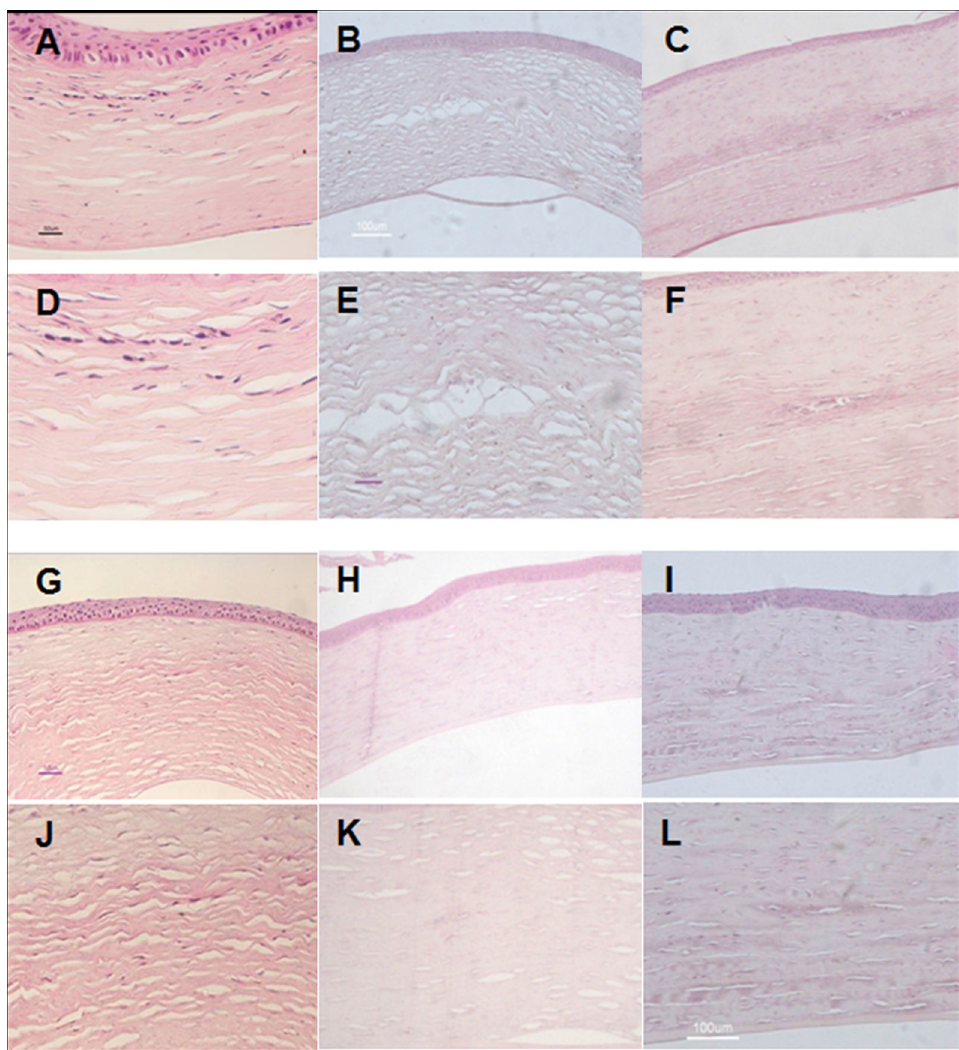
Figure 4. Histological analysis of tissue engineered grafts in each group at different time points. A, D, G, J: autologous rASCs+PLGA group; B, E, H, K: PLGA group; C, F, I, L: Only defect group; A-F: 12 week; G-L: 24 week. HE stained histological sections showed that the corneal epithelial cells and endothelial cells were intact in all groups. Corneas in the group with implantation of autologous rASCs-PLGA had been repaired by newly formed tissue, forming more native structures at 24 weeks than at 12 weeks post transplantation. In PLGA alone and only defect group, collagen remodeling was not successful. Corneas were thinner, collagen arrangement was not in good order, and scars existed (A-C, G-I: Magnification ×100; D-F, J-L: Magnification